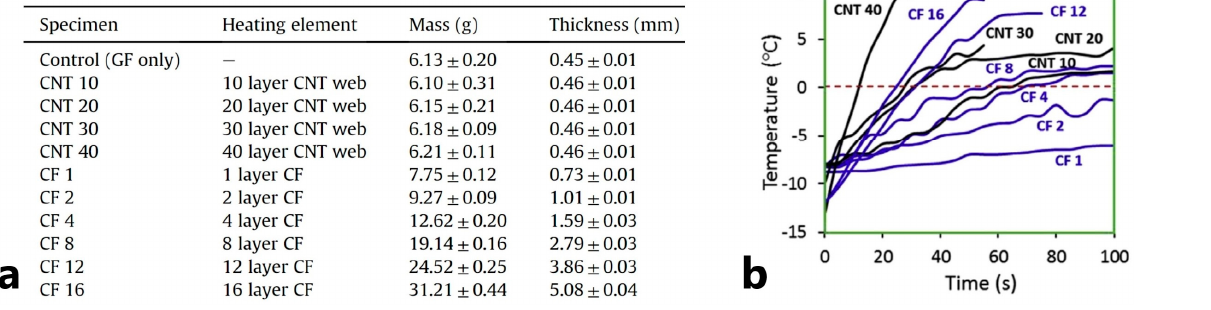
Figure 7. ( a ) Properties of samples with CNT and CF plies, ( b ) de-icing test graph at 16 V (Reprinted with permission from Elsevier, copyright 2018) [62].